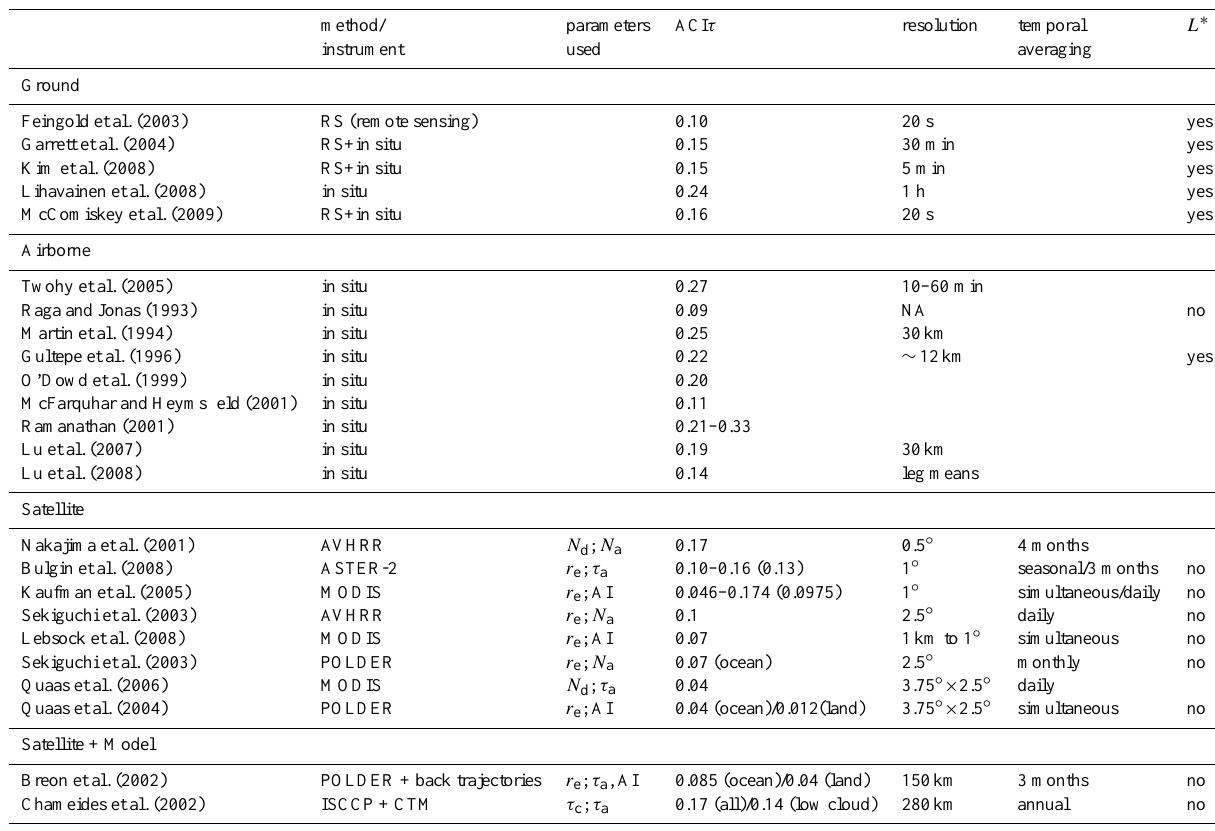
Table 1. References used in Fig 1b. All studies address low or liquid clouds.